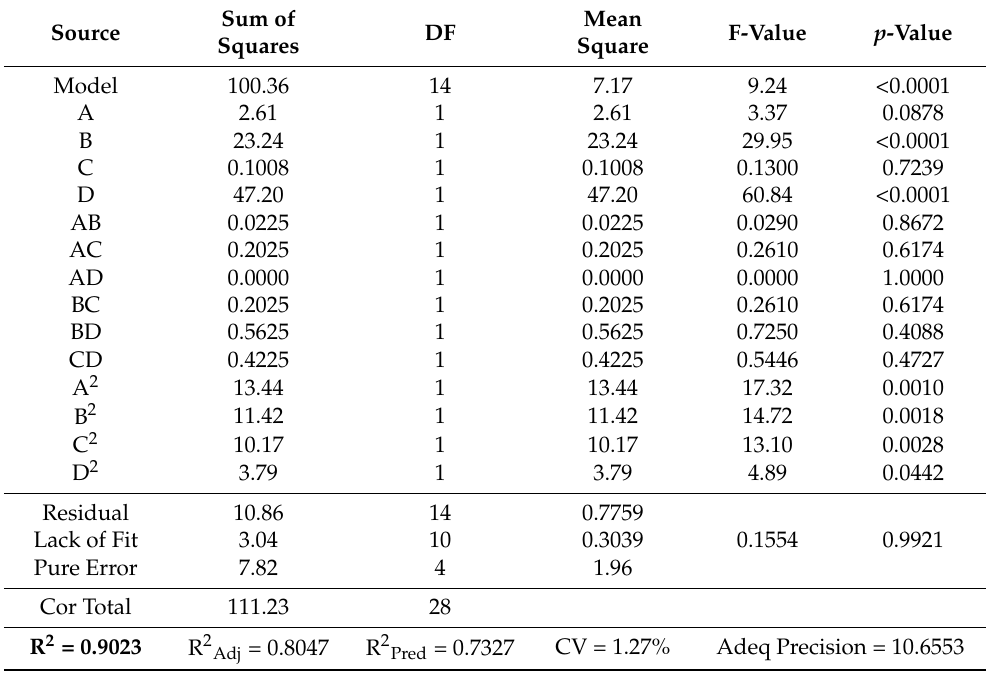
Table 2. Variance analysis of the BBD in derivatization of CPMP-monosaccharide. Sum of Source